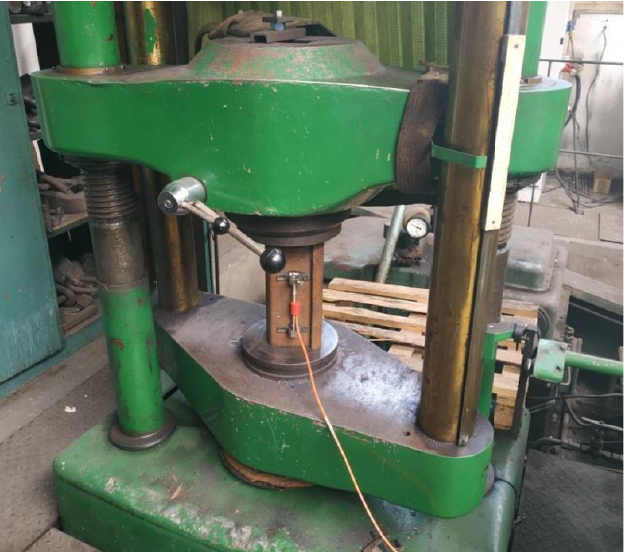
Figure 14. Preliminary research test stand [10].